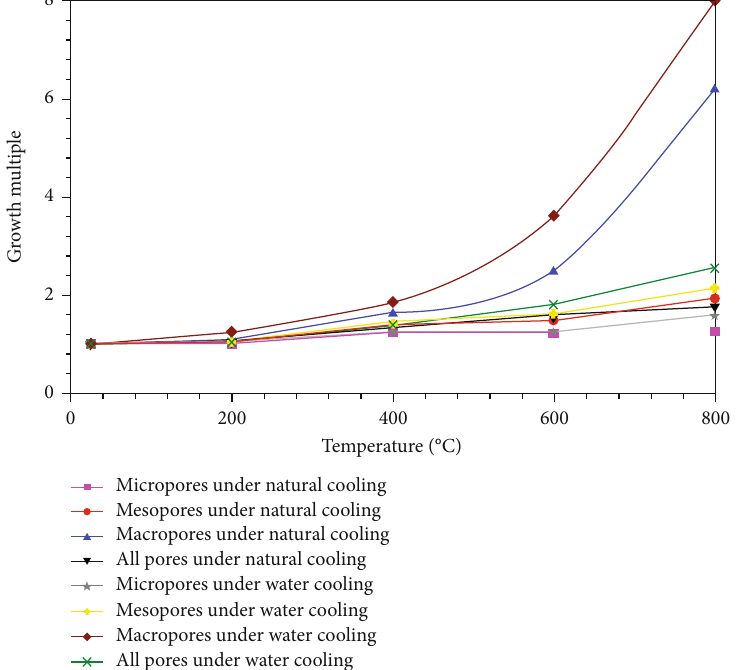
Figure 14: Variation of pores in tight sandstone with temperature under two di ff erent cooling